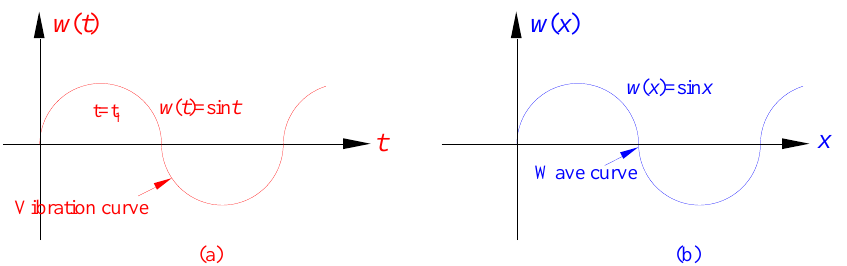
Table 2. Differences with traditional analysis methods.